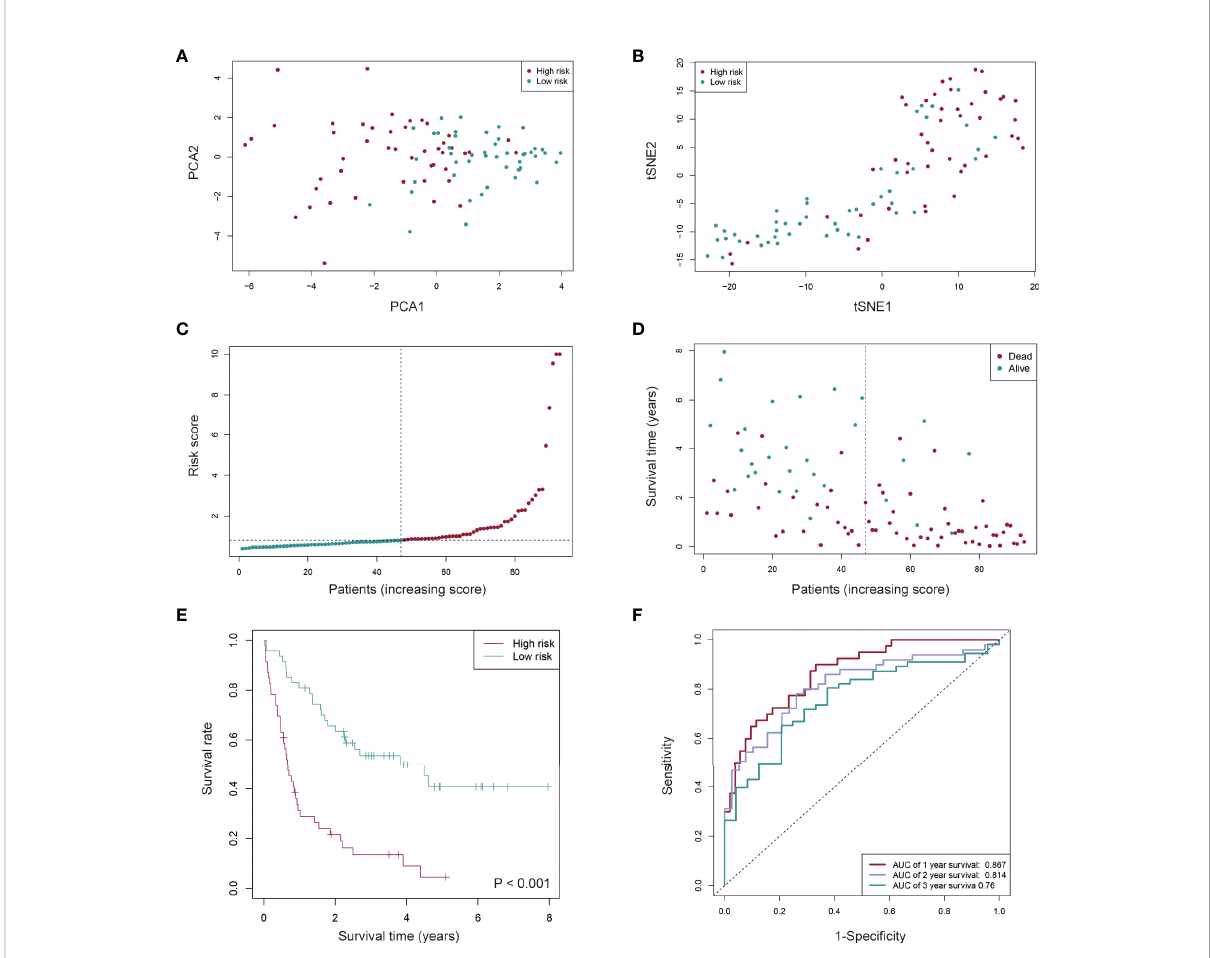
FIGURE 4 Prognostic value of the cuproptosis-related lncRNA signature in AML patients from the TCGA cohort. (A, B) AML patients in distinct risk groups could be separated into two clusters based on the PCA (Principal component analysis) (A) and t-distributed stochastic neighbor embedding (t- SNE) method (B) . (C, D) Distribution of the risk score (C) and survival time of each patient (D) . (E) Kaplan-Meier survival analysis of overall survival (OS) for AML patients with low- and high-risk groups. (F) The sensitivity and speci fi city of the prognostic model for AML patients assessed using the 1-, 2-, and 3-year ROC (receiver operating characteristic) curves and AUC (area under